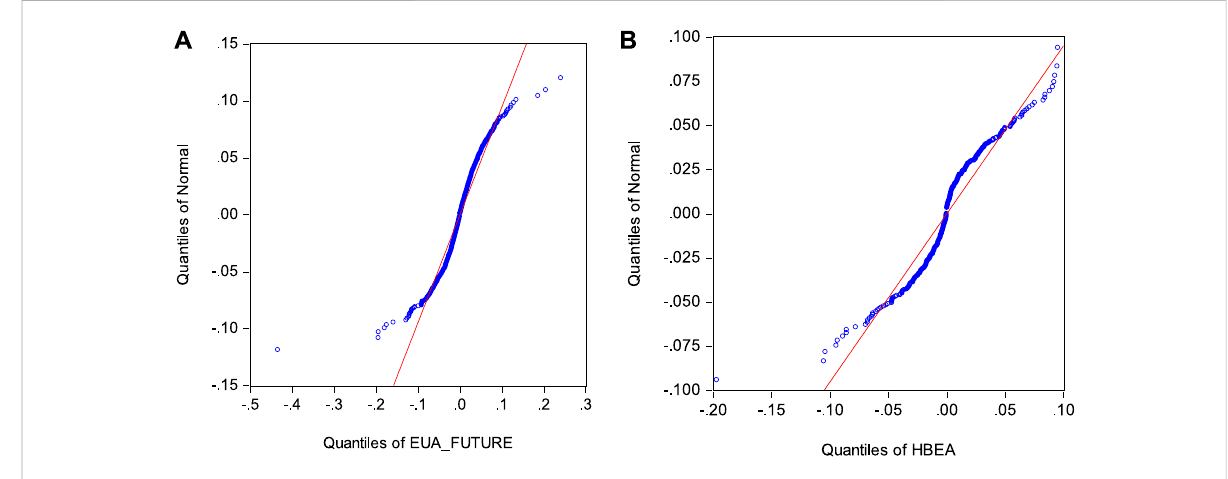
FIGURE 4 Quantile-quantile plots for returns. (A) EUA futures; (B) Hubei spot. The sample period is from January 1, 2013, to December 31, 2020, for EUA futures and from July 1, 2019, to July 30, 2021, for Hubei spot returns.